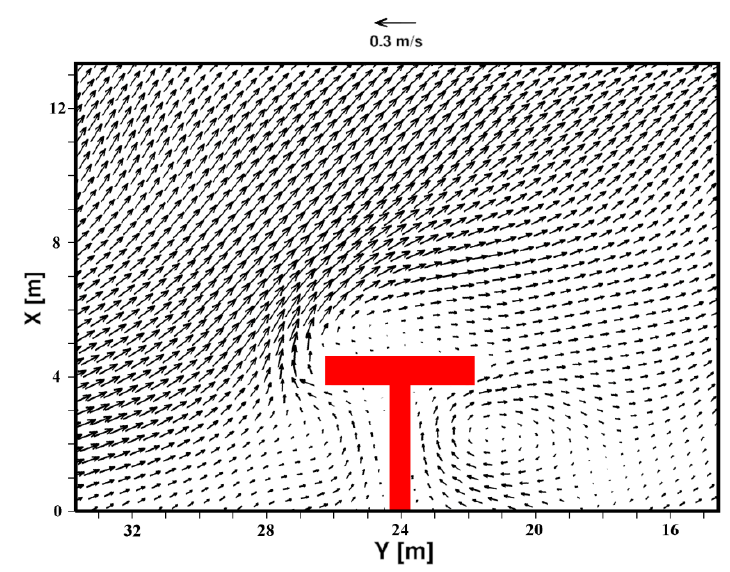
Figure 6. Plan view of the time-averaged velocity field. Near the bed, at a relative position from the free surface of 𝑧/𝑧 𝑏 = 0.933 .